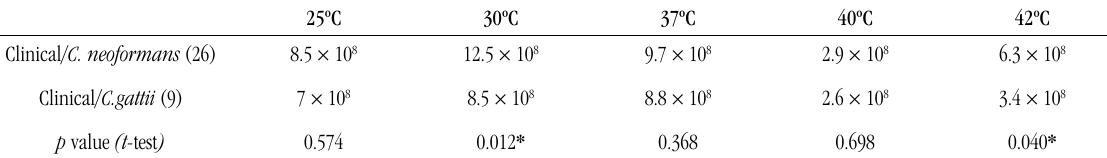
tABLE 2 – Mean microorganism concentrations in the seventh day of thermotolerance reading with only clinical samples